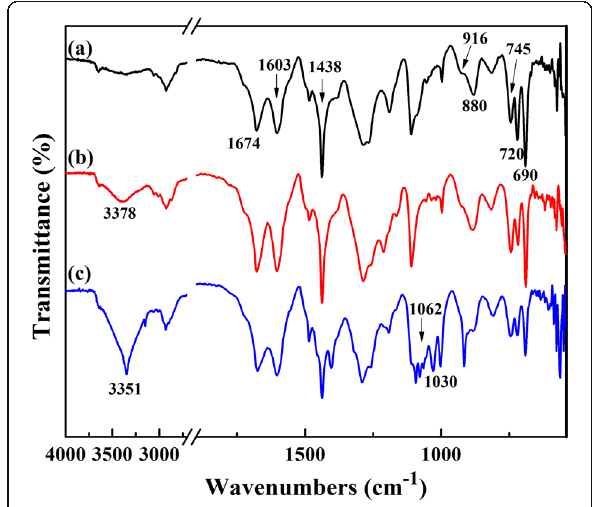
Fig. 2 FT-IR spectra of (a) TPDB, (b) TPDB-BP, and (c) TPDB-BP-TEA. The distinct bands corresponding to the P – C=C (1674 cm − 1 ) in PPh 3 and aromatic ring stretching vibrations (1603 – 1438 cm − 1 ), as well as to the stretching vibrations of C − H in aromatic ring (916, 880, 745, 720, and 690 cm − 1 ) indicates the presence of both PPh 3 and DB groups in TPDB. TPDB-PA shows a moderate intensity broad absorption band at 3378 cm − 1 , which is corresponding to the stretching vibration of the – OH. After further modified by TEA, the intensity of – OH vibration at 3351 cm − 1 for TPDB-BP-TEA significantly increased. Besides, the new bands appeared at 1062 and 1030 cm − 1 are assigned to the stretching vibrations of C – N and C – O in TEA, respectively